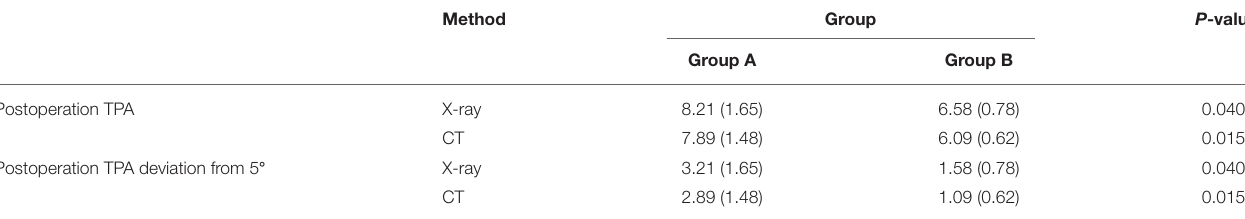
TABLE 2 | Comparison of the postoperative tibial plateau angle and deviation according to the surgical method.